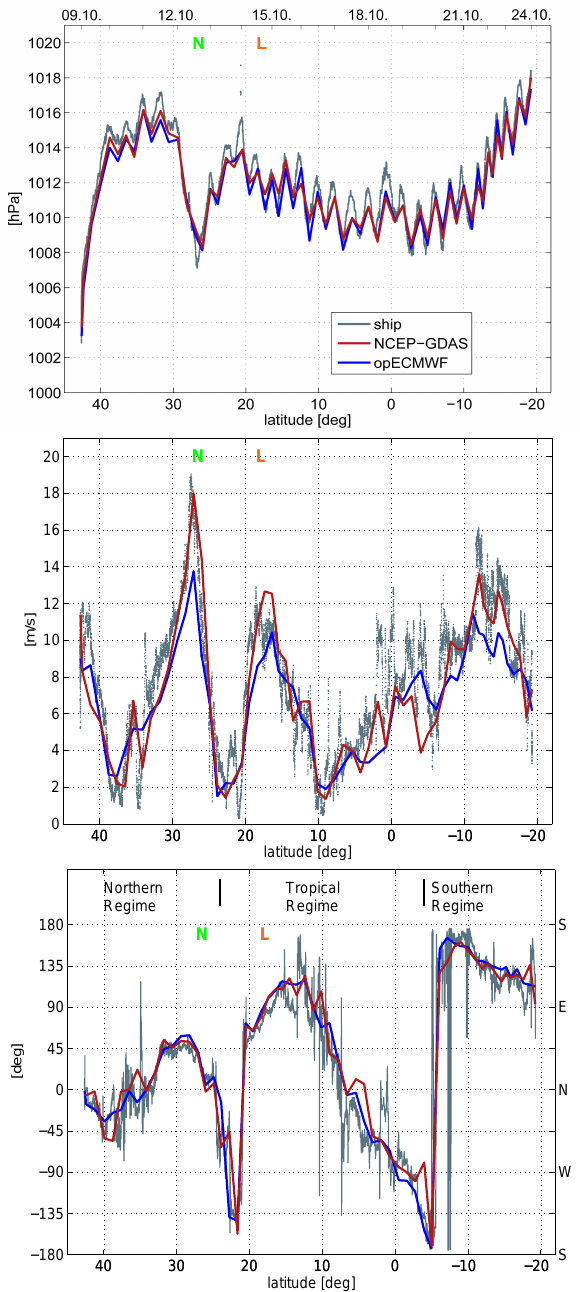
Fig. 3. Data intercomparison between ship measurements and two different data assimilations from: (Top) sea level pressure (hPa), (Middle) mean wind speed (ms − 1 ), (Bottom) mean wind direction (in ◦ and compass direction) and atmospheric regimes during Octo- ber 2009. The ship measurements are displayed as 10min averages; the NCEP-GDAS (red lines) and opECMWF (blue lines) data at 6 hourly intervals.